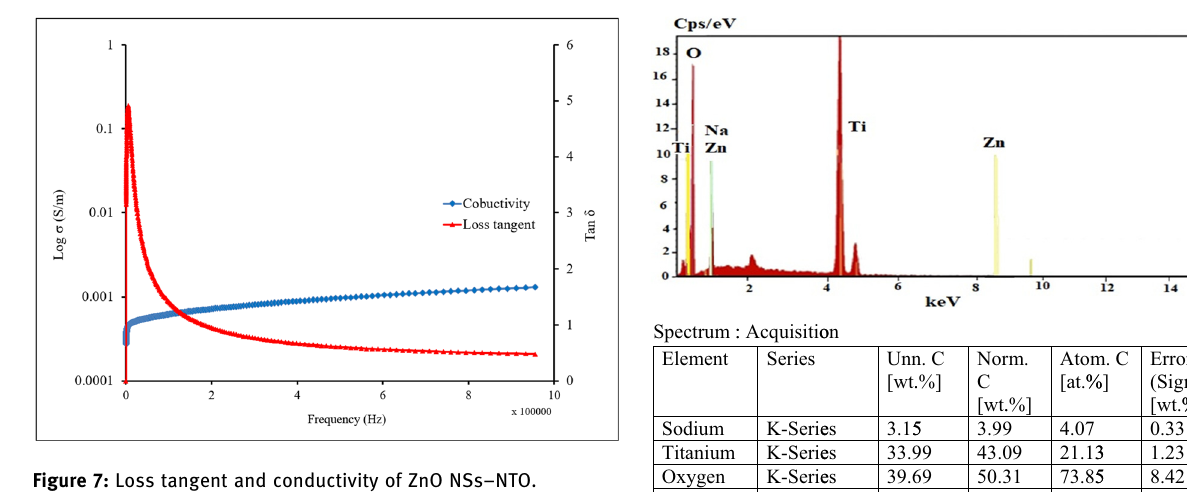
Figure 7: Loss tangent and conductivity of ZnO NSs – NTO.